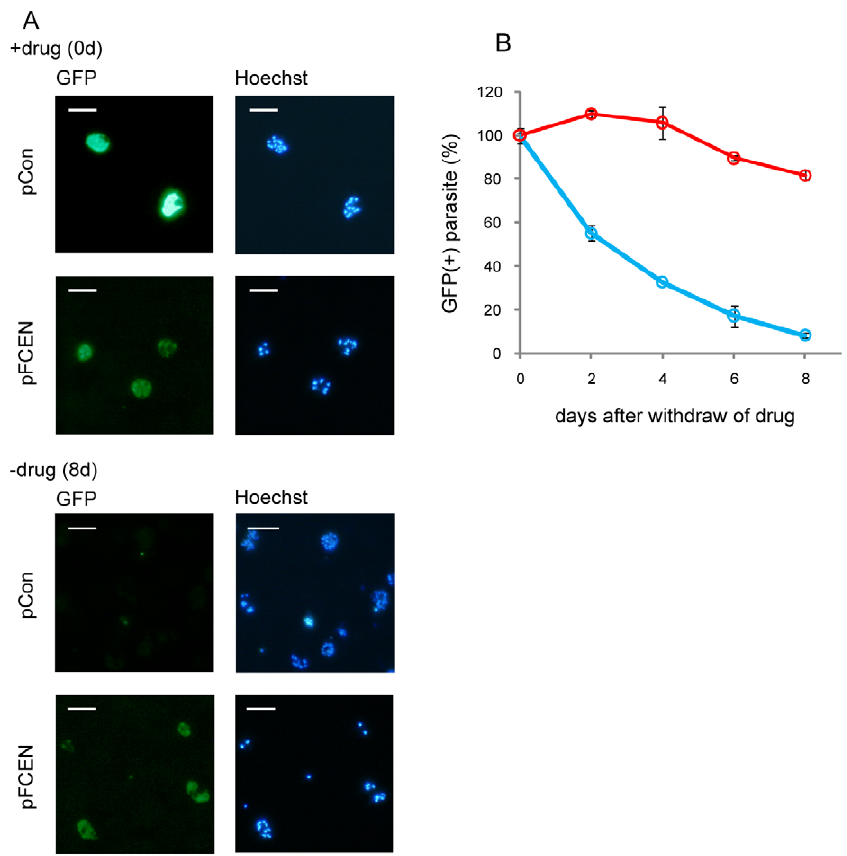
Figure 4. Stable Maintenance of pFCEN in the Parasites. (A) The GFP expression of the parasites transfected with pFCEN and pCon were monitored in the presence of the selective drug (upper panel) and at 8 days after the removal of the drug. The nuclei of the parasites were stained with Hoechst-33258. The scale bars indicate 10 m m. (B) The percentages of GFP-positive parasites in the absence of the drug were calculated as described in the Materials and Methods. The red and blue lines indicate the percentage of GFP-positive parasites transfected with pFCEN and pCon, respectively.